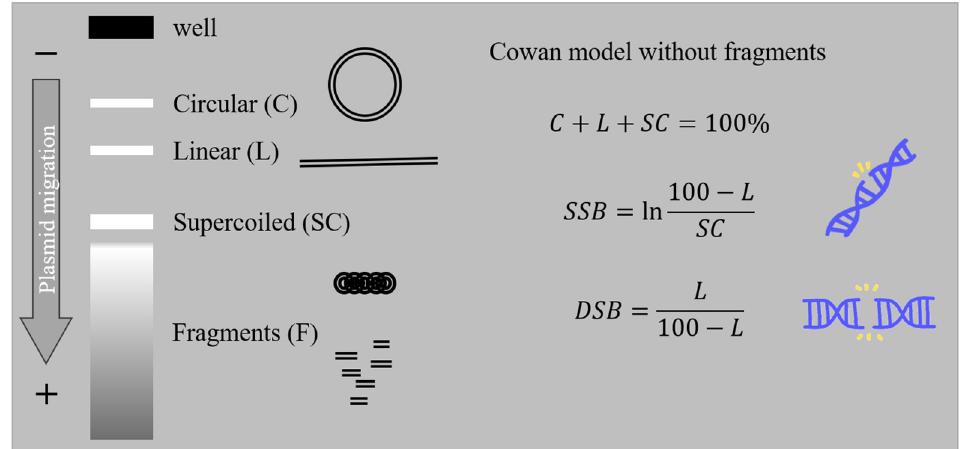
Figure 8. The electrophoresis concept: Each plasmid sample is added in a well (cathode side), electric field is applied at the gel edges and under the electric potential difference, the negatively charged DNA migrates to the anode side through the gel net. Due to the net-like agarose gel, different DNA forms are separated according to the size of each form that created three clearly distinguishable bands. Supercoiled (SC) plasmid (small-sized twisted DNA) is moving easier and faster, crossing a larger pathway inside the gel and appearing as a more distant band. The large circular (C) and linear (L) molecules have lower mobility than SC, and they are trapped in areas closer to the well. Therefore, the unfolded C appears as higher band in the gel, and L forms a band in between. Additionally, the smaller DNA fragments (F) of higher mobility appear as a smear inside the gel. SC is the compact initial DNA with no break; C is caused by the cleavage of one DNA strand (SSB) and L by the cleavage of two strands (DSB). F results from further nicking cannot be safely measured via AGE and is excluded from present analysis. By defining the amount of SC, C and L and employing Cowan model [45] (equations above), we translate it into number of SSB and